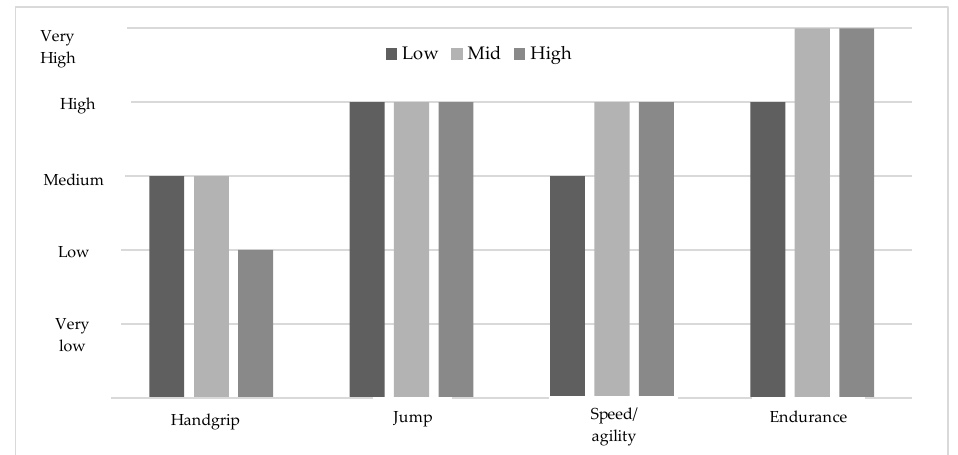
Figure 7. Mean levels of the physical fitness variables in the girls based on the average levels established by Ortega et al. (2011) [59].